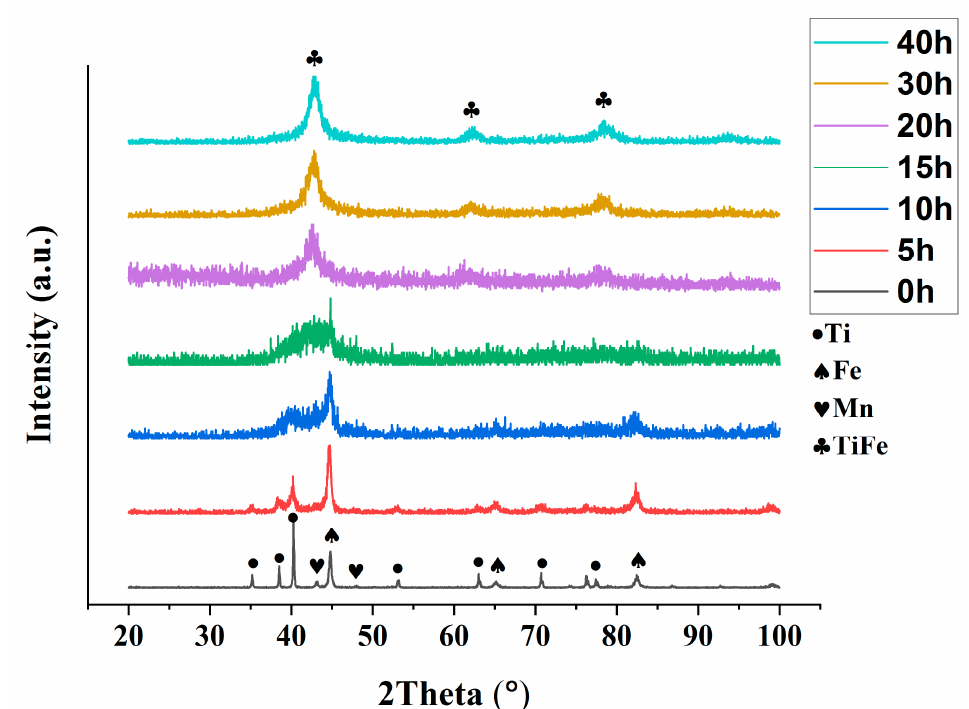
Figure 2. XRD patterns of Fe10 milled product after different milling times.